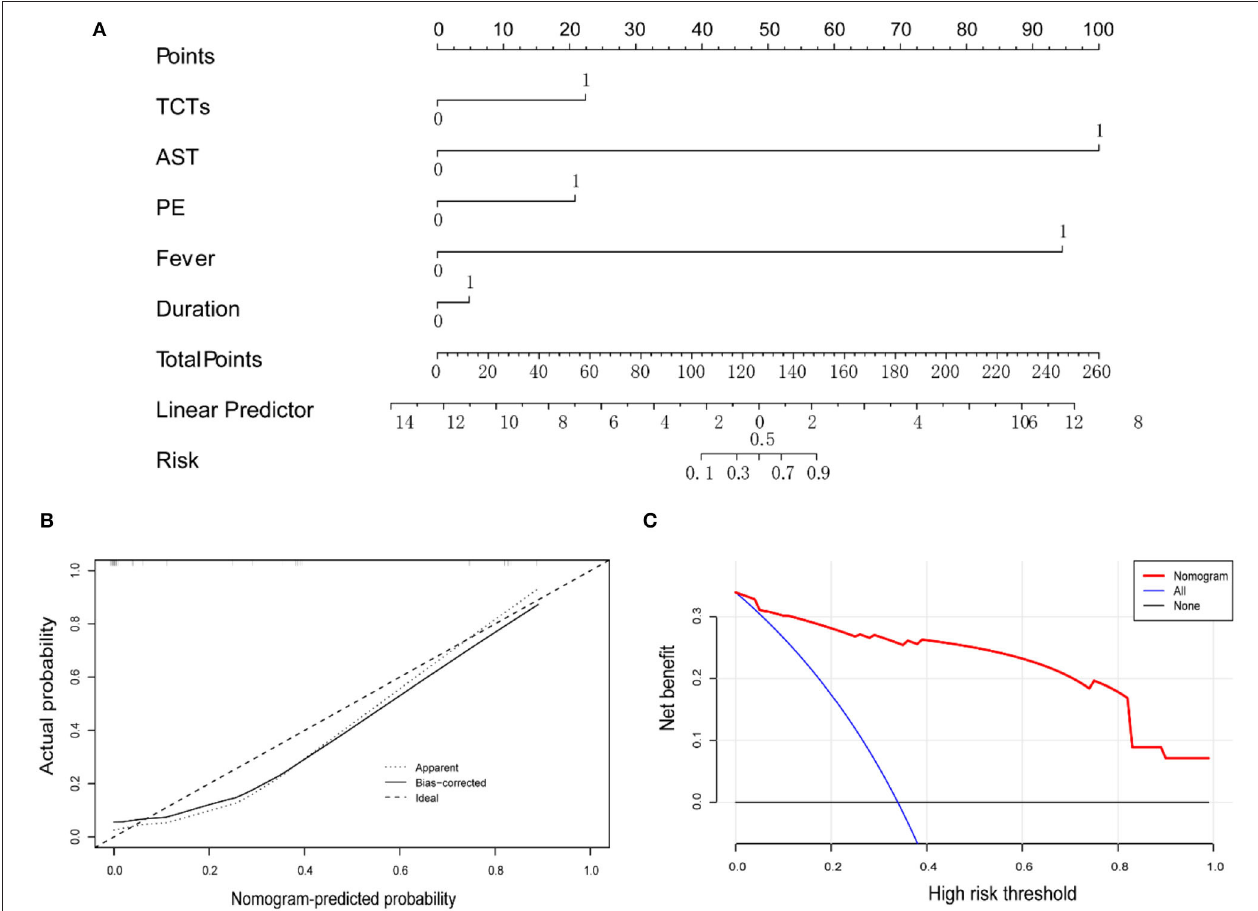
FIGURE 4 | (A) Nomogram predicting the prognosis of MDA5 + DM-ILD, while all predictors are binary variables. (B) Calibration curve of the nomogram. (C) DCA of the